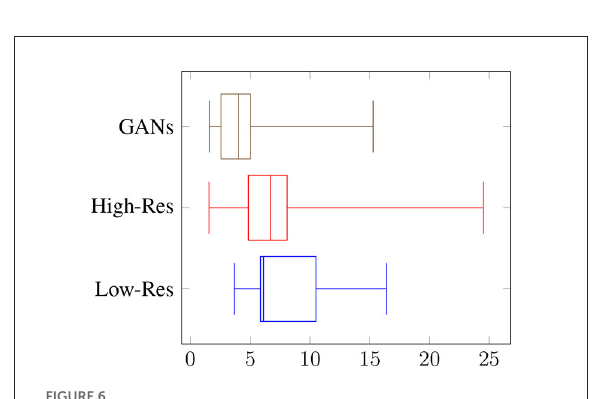
FIGURE6 Visual assessment of generated datasets: RMSE on number of fake